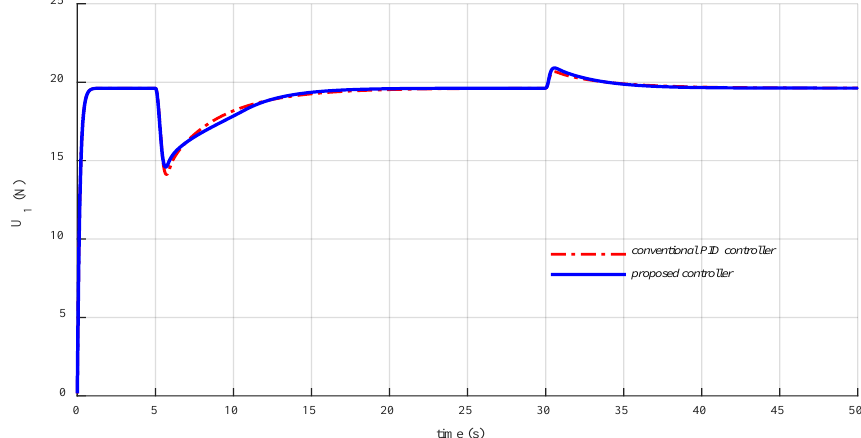
Figure 11. Comparison of the control signal, U 1 , between our new controller and a conventional PID controller for Scenario 1.